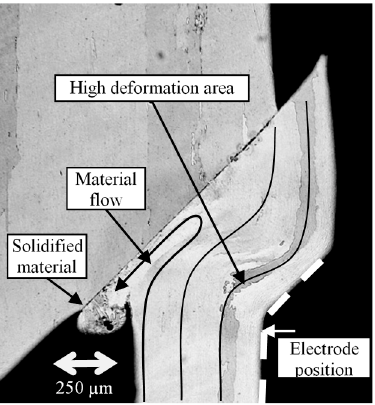
Figure 5. Evidence of the material deformation with the selected parameters ( F w ; I w ; t w ; C s ) = (2600 N; 14 kA; 10 ms; 0.8 mm).